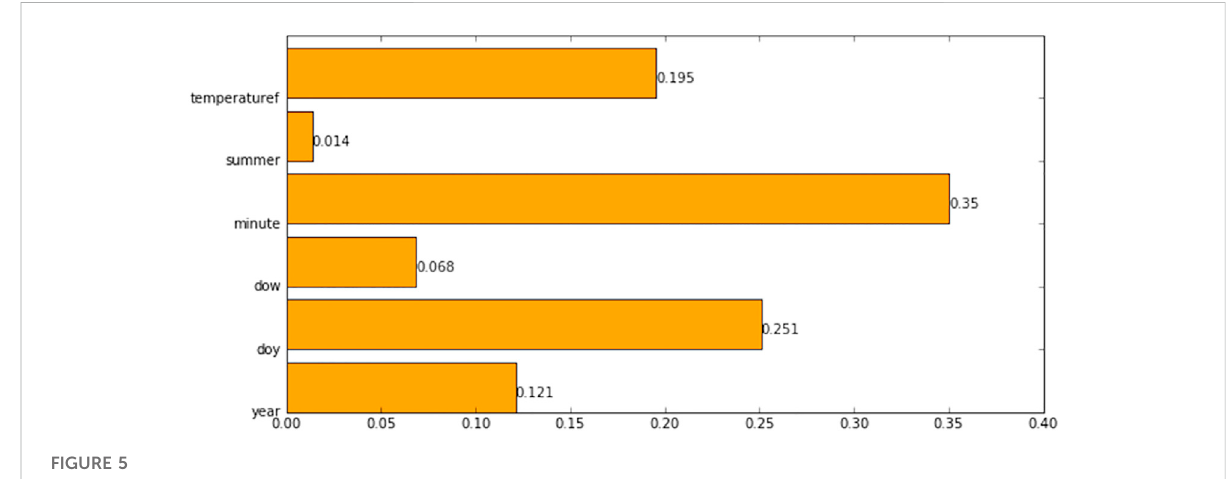
FIGURE 5 Feature importance of each factor.